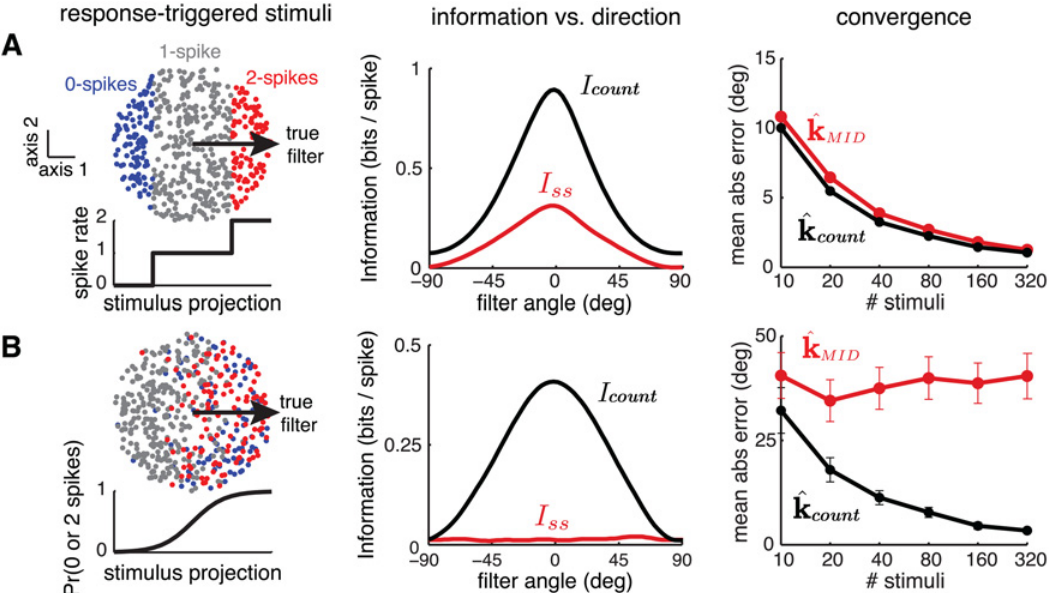
Fig 7. Two examples illustrating sub-optimality of MID under discrete (non-Poisson) spiking. In both cases, stimuli were uniformly distributed within the unit circle and the simulated neuron ’ s response depended on a 1D projection of the stimulus onto the horizontal axis ( θ = 0). Each stimulus evoked 0, 1, or 2 spikes. (A) Deterministic neuron. Left : Scatter plot of stimuli labelled by number of spikes evoked, and the piece-wise constant nonlinearity governing the response (below). The nonlinearity sets the response count deterministically, thus dramatically violating Poisson expectations. Middle : information vs. axis of projection. The total information I count reflects the information from 0-, 1-, and 2-spike responses (treated as distinct symbols), while the single-spike information I ss ignores silences and treats 2-spike responses as two samples from p ( s j spike ). Right : Average absolute error in sample size; the latter achieves 18% lower error due to its sensitivity to the non-Poisson structure of the response. (B) Stochastic neuron with sigmoidal nonlinearity controlling the stochasticity of responses. The neuron transitions from almost always emitting 1 spike for large negative stimulus projections, to generating either 0 or 2 spikes with equal probability at large positive projections. Here, the nonlinearity does not modulate the mean spike rate, so I ^ ss is approximately zero for all stimulus projections (middle) and the MID estimator does not converge (right). However, the LNC model is sensitive to the change in conditional response distribution. Equation (37) details the relationship between I count and L lnc , so that this figure can be interpreted from either an information-theoretic or likelihood-based